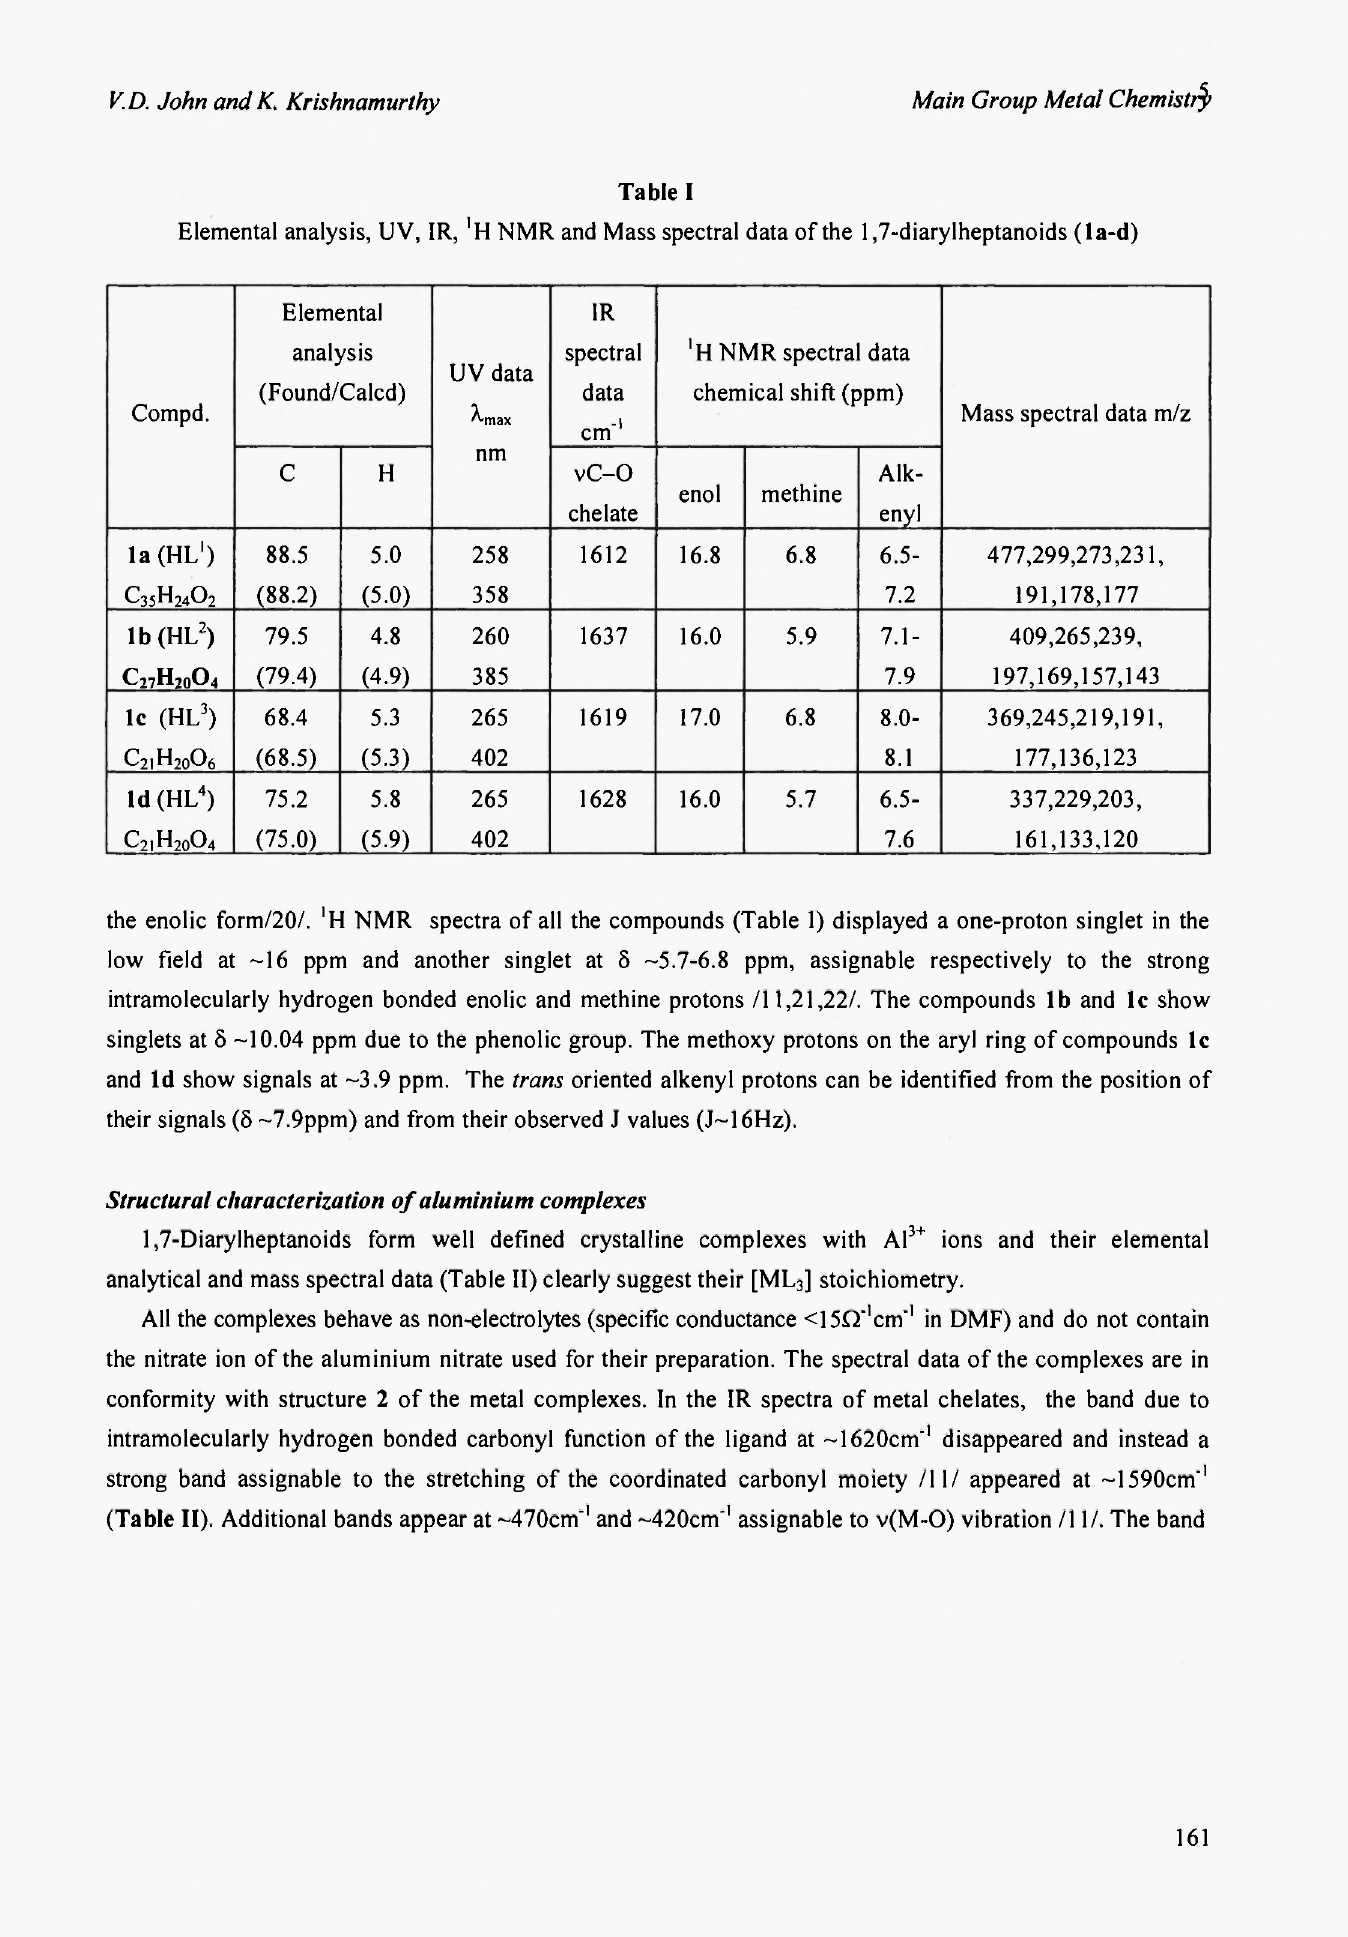
Elemental IR analysis